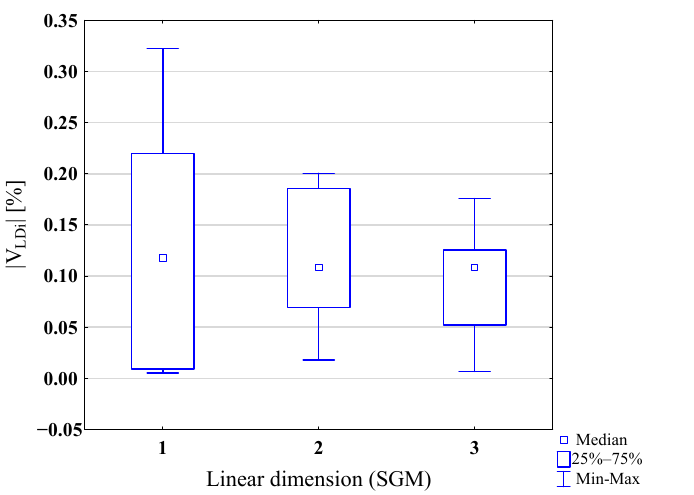
Figure 9. Distribution of absolute values of the VLDi coefficient for the examined linear dimen- sions (SGM).